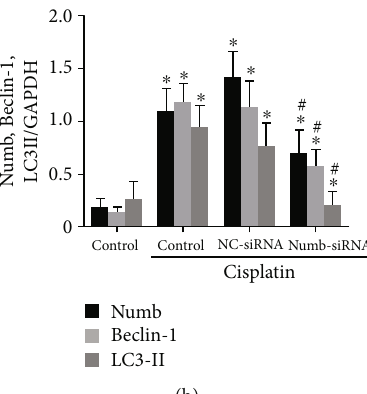
Figure 1: Depletion of Numb inhibits renal autophagy in AKI model induced by Cisplatin. (a) The protein expression of Numb, Beclin-1, and LC3-II in the kidney from mice 3 days after Cisplatin injection was analyzed by Western blotting. (b) Relative expression of Numb, Beclin-1, and LC3-II to GAPDH was represented in graphic. (c) The level of creatinine in serum. (d) Serum BUN was assayed. (e) HE staining of kidney. (f) Histology score was analyzed. Data are presented as means ± SD, n =5. ∗ P < 0 : 05 versus Control. # P < 0 : 05 versus scramble siRNA-injected mice treated with Cisplatin. (g) The protein expression of Numb, Beclin-1, and LC3-II in the kidney of mice in each group. (h) Relative expression of Numb, Beclin-1, and LC3-II to GAPDH was represented in graphic. Data are shown with means ± SD, n =5. ∗ P < 0 : 05 versus Control group. # P < 0 : 05 versus scramble siRNA-injected mice with Cisplatin